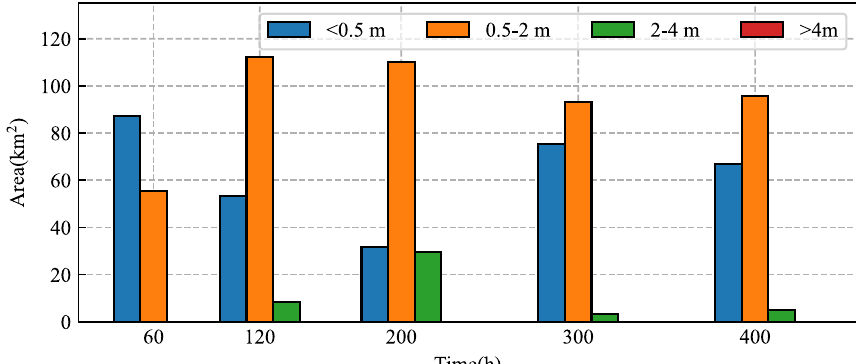
Fig. 5 Water depth and inundation area in different periods of “92.8” flood